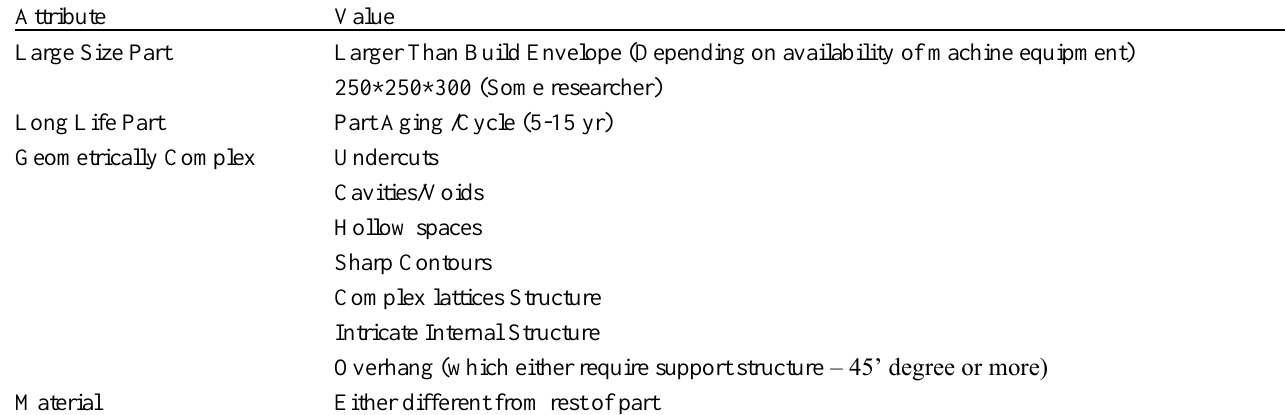
Rule Template for AM Pre-Planning Requirement